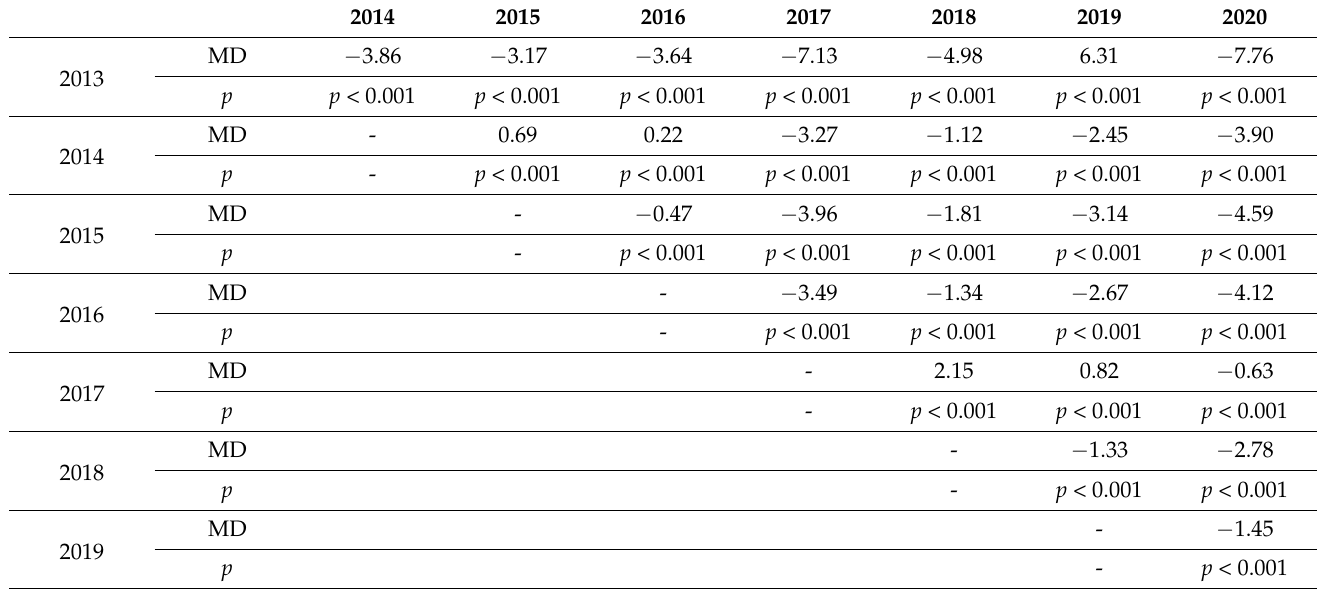
Table 6. Comparison of defibrillation delivering in the case of VF and pVT between individual editions of the Championships.